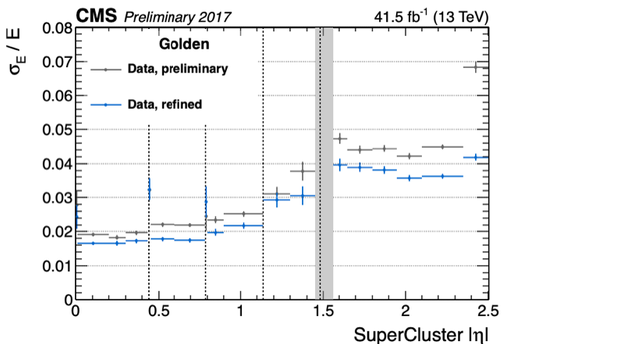
Figure 2. Relative electron (ECAL) energy resolution unfolded in bins of pseudorapidity for the ECAL barrel and the ECAL endcaps. Electrons from Z → ee decays are used. The resolution measured on 2017 data is shown for very low bremsstrahlung electrons (‘golden’). The relative resolution is extracted from an unbinned likelihood fit to Z → ee events, using a Breit-Wigner function convoluted with Gaussian as the signal